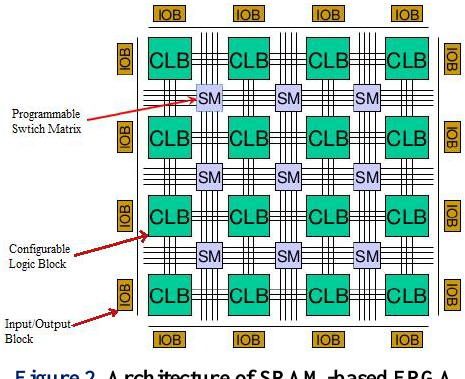
Figure 2. Architecture of SRAM-based FPGA.